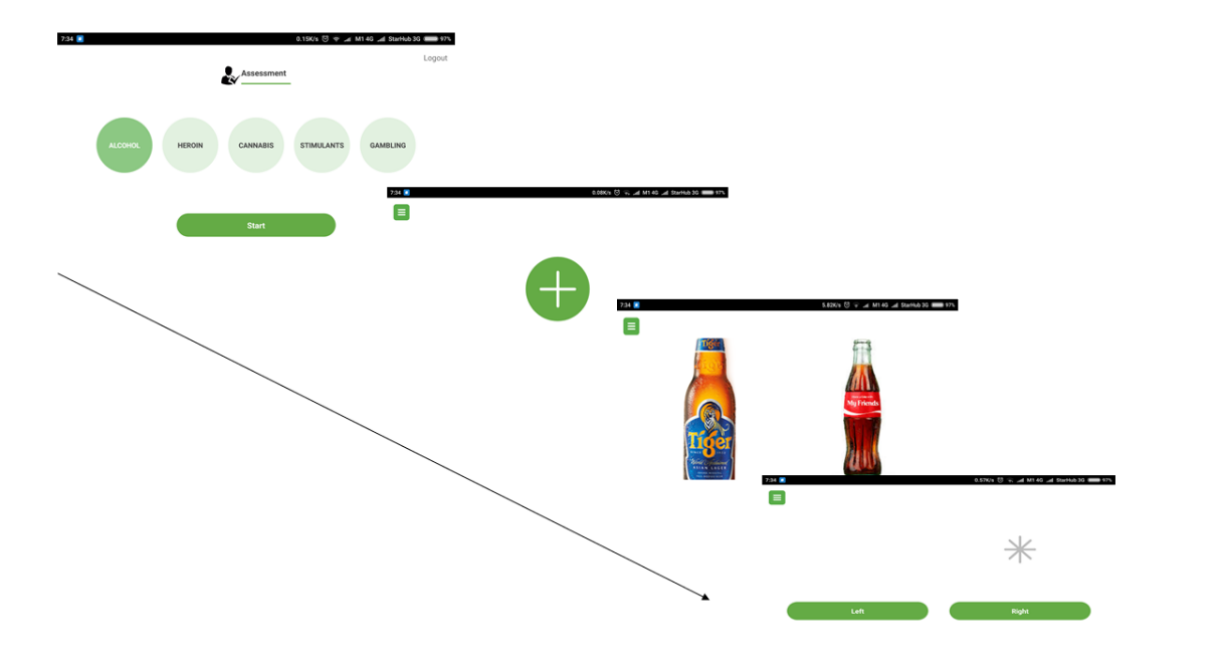
Figure 1. Overview of the existing mobile attention bias